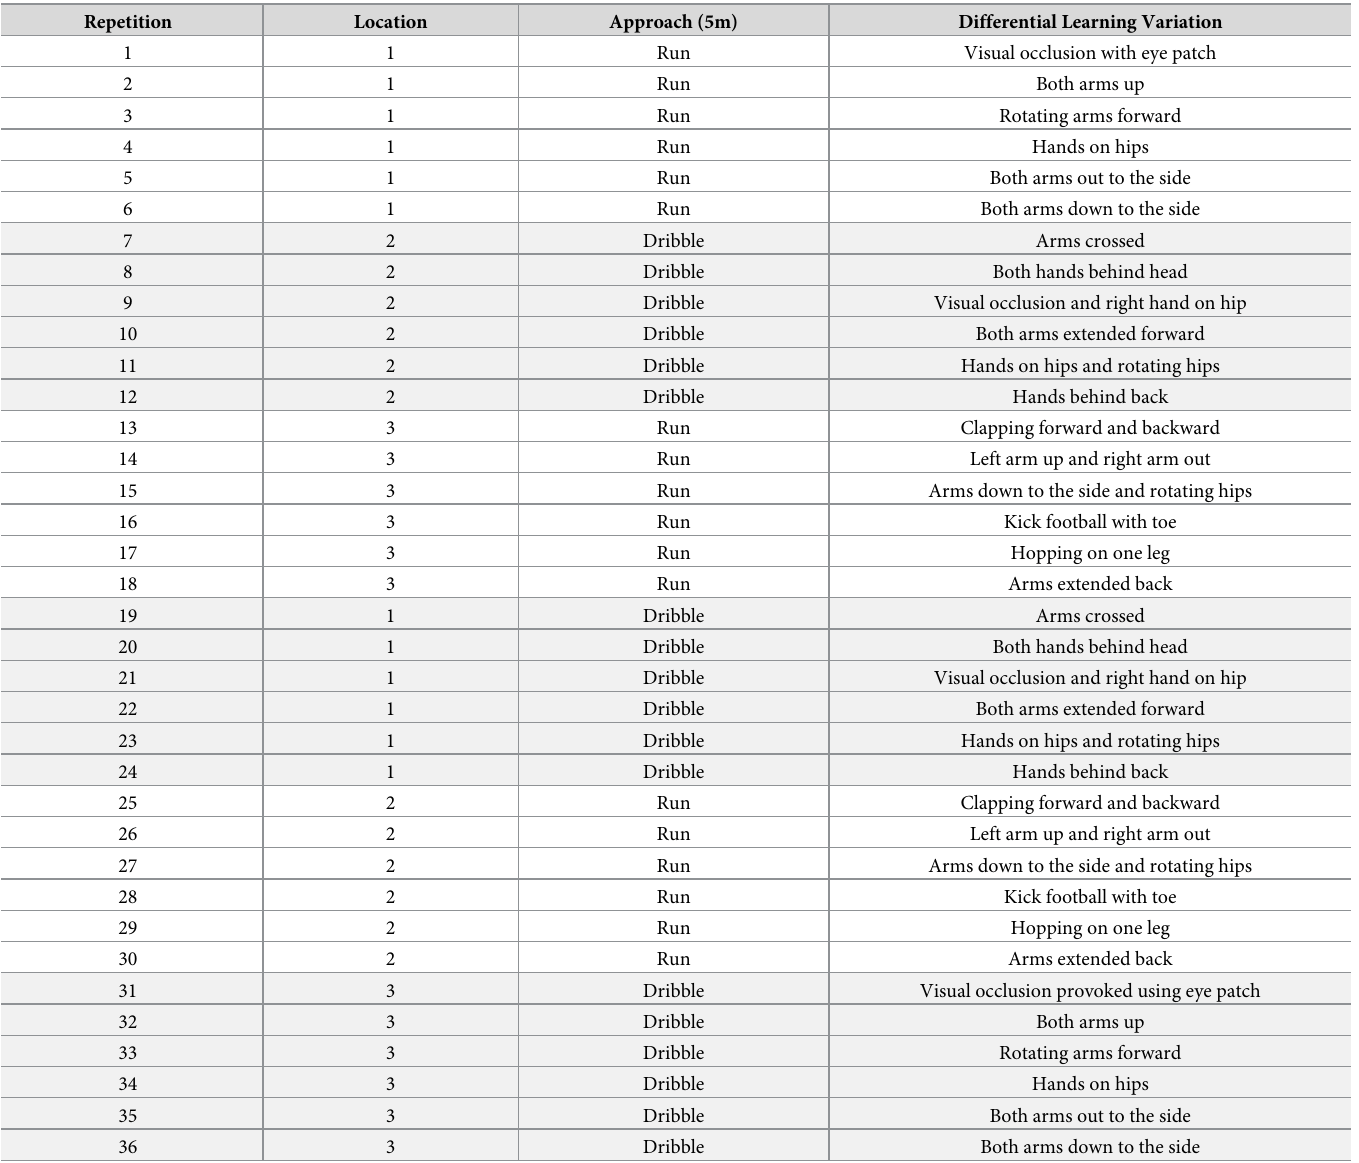
Table 1. Example of the variations performed in differential learning